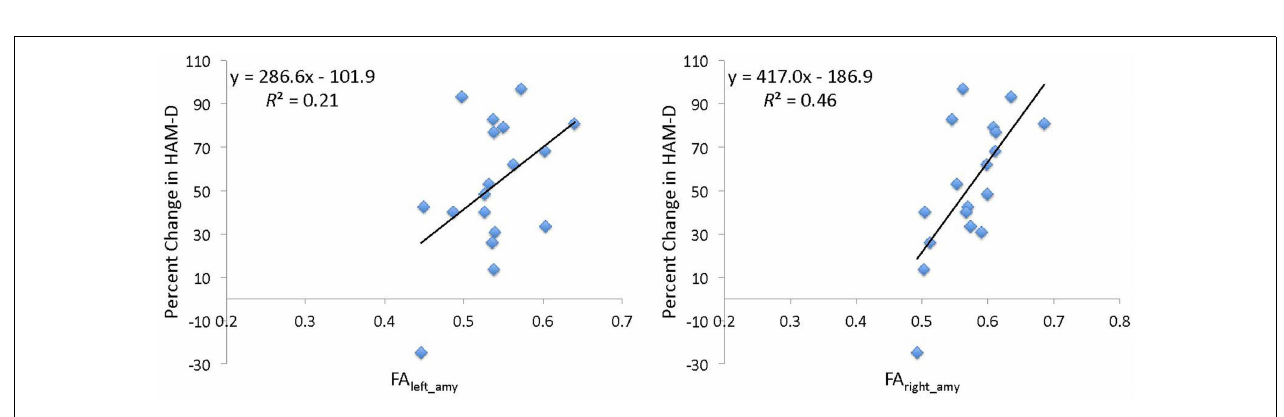
of FA within the tracts from the midbrain/raphe to the left (FA left_amy ) or right (FA right_amy ) amygdala.The linear regression fits (black lines) and parameters are